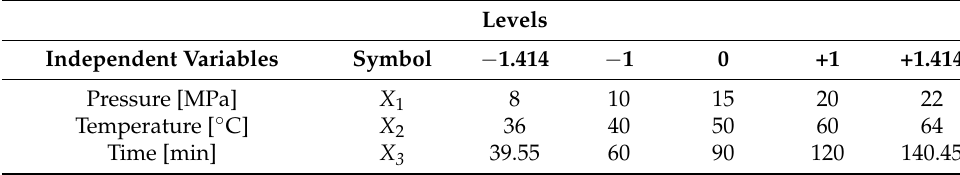
Table 1. The uncoded and coded levels of independent variables used in the RSM.